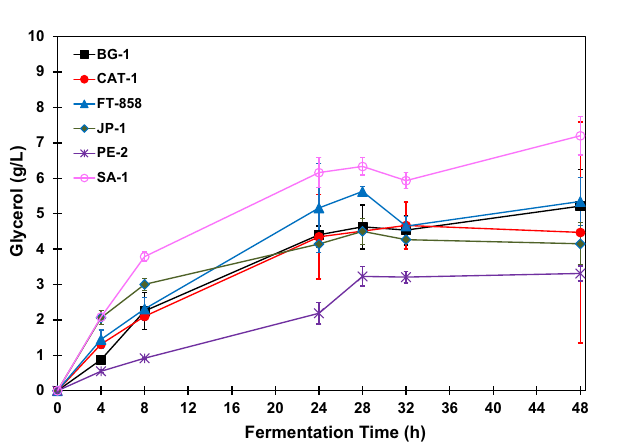
Figure 9. Glycerol concentration profiles during BRS AG rice fermentations with S. cerevisiae strains. The error bar represents the standard deviation from the essays carried out in